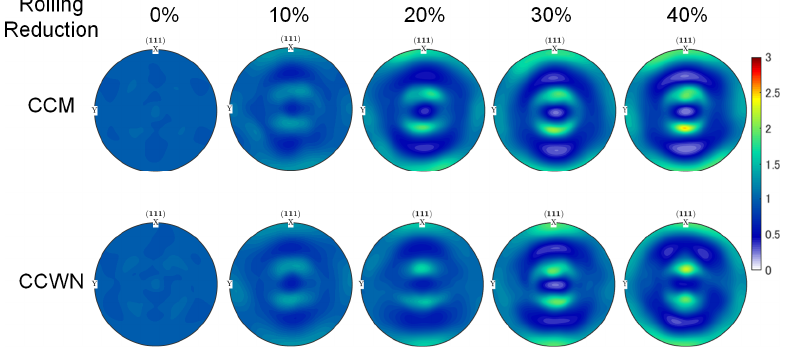
Figure 2. {111} pole figures for face centered cubic (FCC) phases in the Co–29Cr–6Mo (CCM) and Co–20Cr–15W–10Ni (CCWN) alloys at various rolling reductions. The pole densities are expressed as multiples of the random density by color.